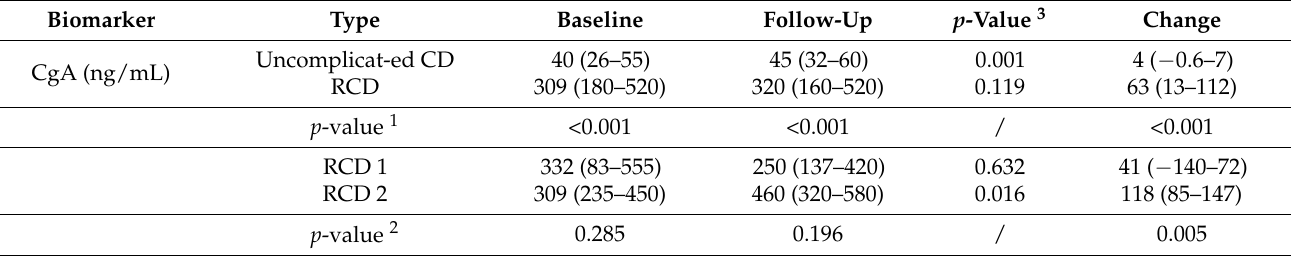
Table 1. Biomarkers values (median and IQR) at baseline and